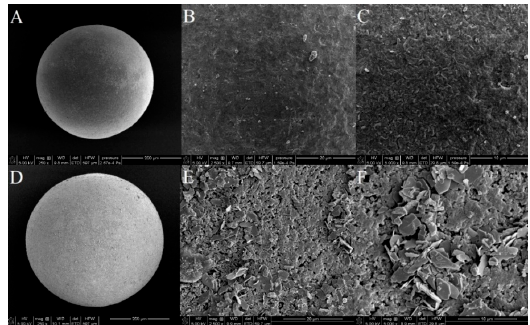
Figure 2. SEM images of X np before ( A – C ) and after the modification with La(III) ions ( D – F ) at various magnifications (250 × ; 2500 × and 5000 × ).